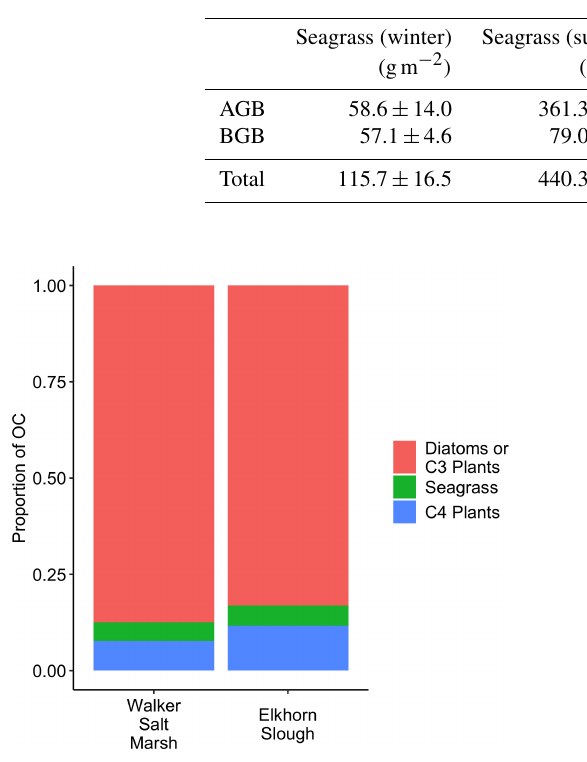
Table 2. Living seagrass aboveground biomass (AGB) and belowground biomass (BGB) were collected in Tom’s Point seagrass meadow (Fig. 1b) in both summer and winter (gm − 2 ) . Total seagrass wrack delivered to Walker Salt Marsh was quantified as AGB and BGB (gm − 2 ) and converted to carbon (gCm − 2 ) using a 31.6% carbon conversion rate.